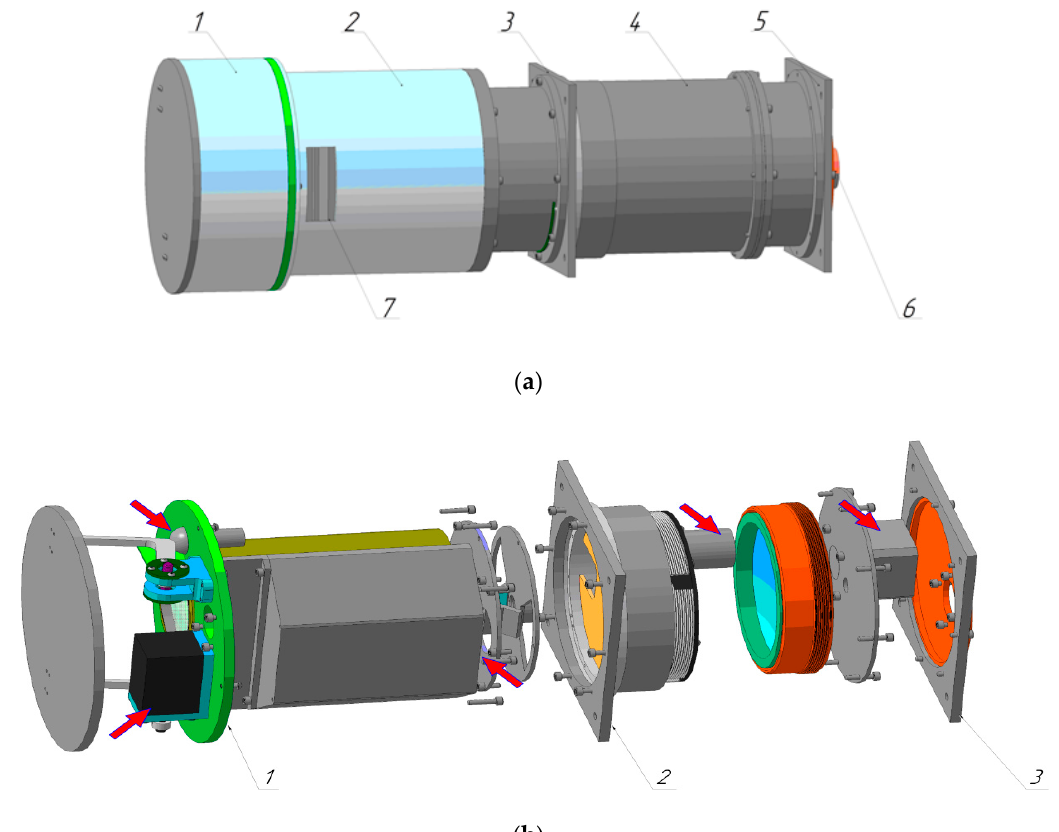
Figure 1. Appearance of hyperspectrometer: ( a ) with external housing: 1 : cover unit, 2 : case to protect the objective lens and fasten the cover unit to the hyperspectrometer, 3 and 5 : brackets for fastening to a space vehicle, 4 : hyperspectrometer case, 6 : connector for plugging in thermal and terminal sensors, 7 : hatch for connector access, and ( b ) without external housing: 1 , 2 , 3 : units for fastening the spectrometer to a space vehicle. Mechanisms for optical calibration and moving the mirror and the diffraction grating are shown by arrows.